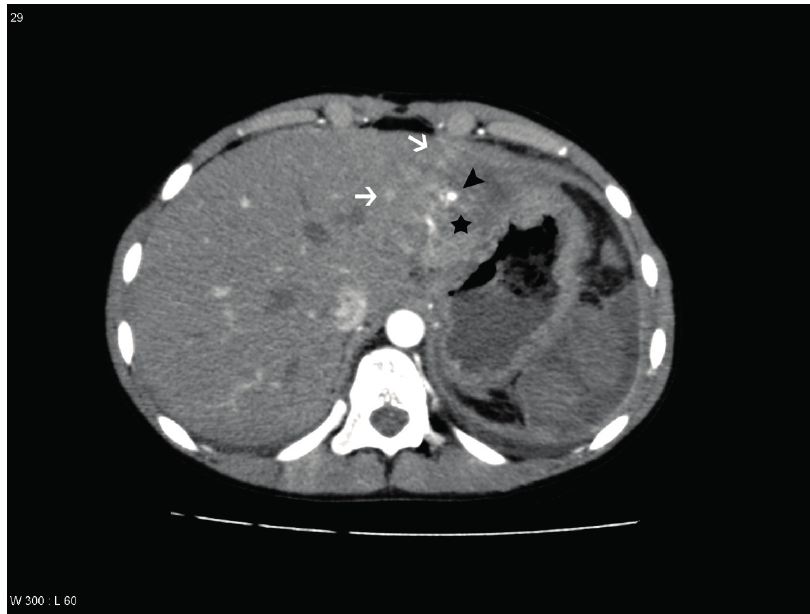
Figure 1. Patient with a pseudoaneurysm within the liver lesion in segment 2, which was confirmed by digital subtraction angiography (DSA) and treated with embolization. Areas with transient hepatic attenuation difference (THAD) surround the lesion. The liver lesion is marked with a black star, the areas with THAD are marked with white arrows and the pseudoaneurysm is marked with a black arrowhead.